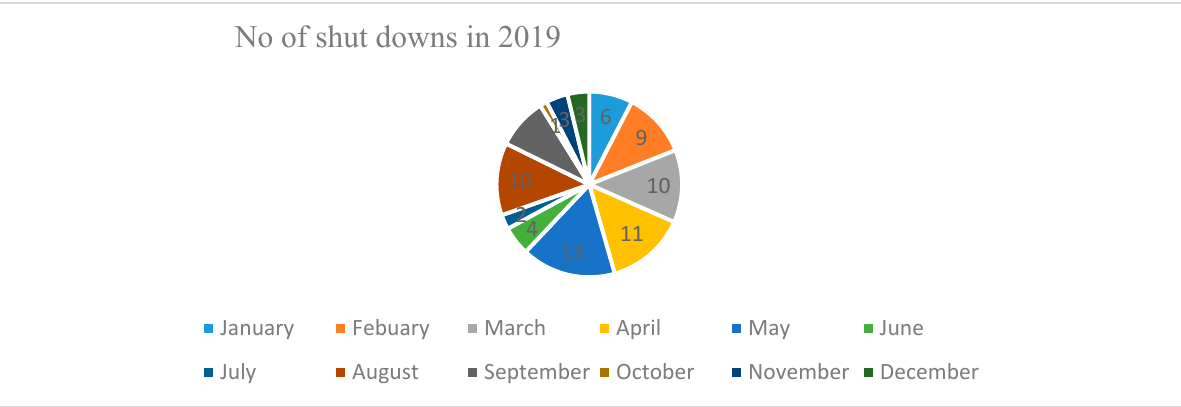
Figure 10. Simulated average peak demand for the year 2021.